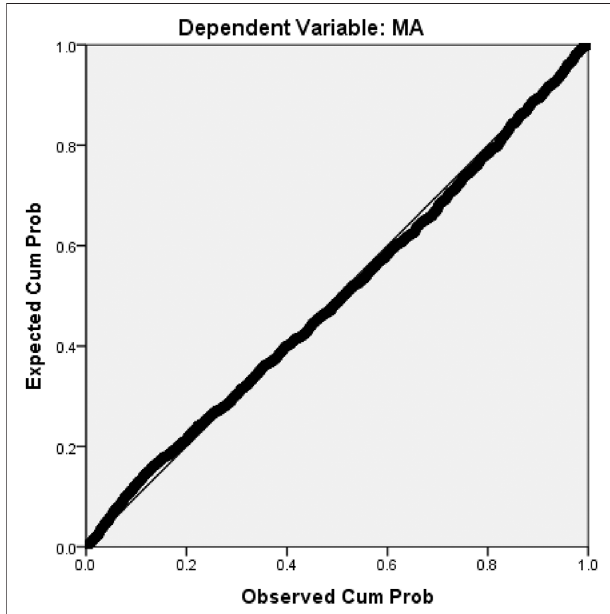
FIGURE 2 | Normal P-P-plot of the regression standardised